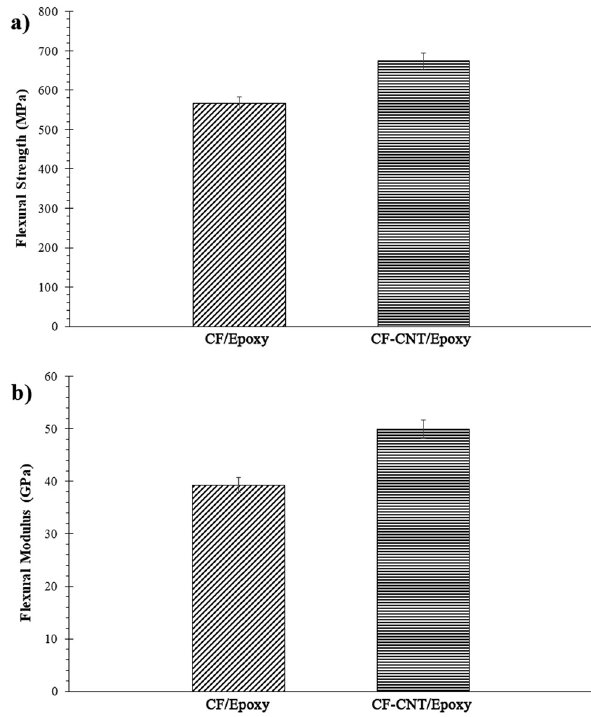
Figure 8: Flexural properties of CF/epoxy and CF – CNT/epoxy in terms of ( a ) ultimate fl exural strength and ( b ) fl exural